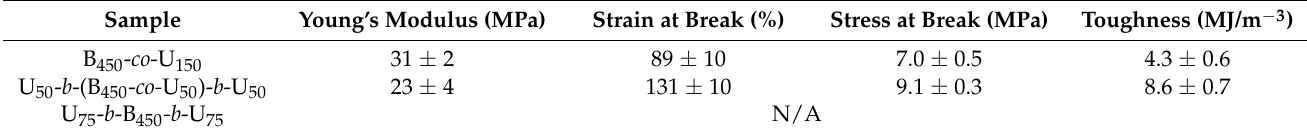
Table 2. Summary of tensile testing derived from the stress-strain curve (Figure S8).